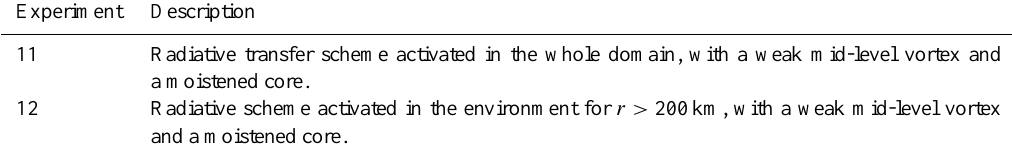
Table 3. Radiative transfer scheme activated with a mid-level vortex and a moistened core. Experiment Description